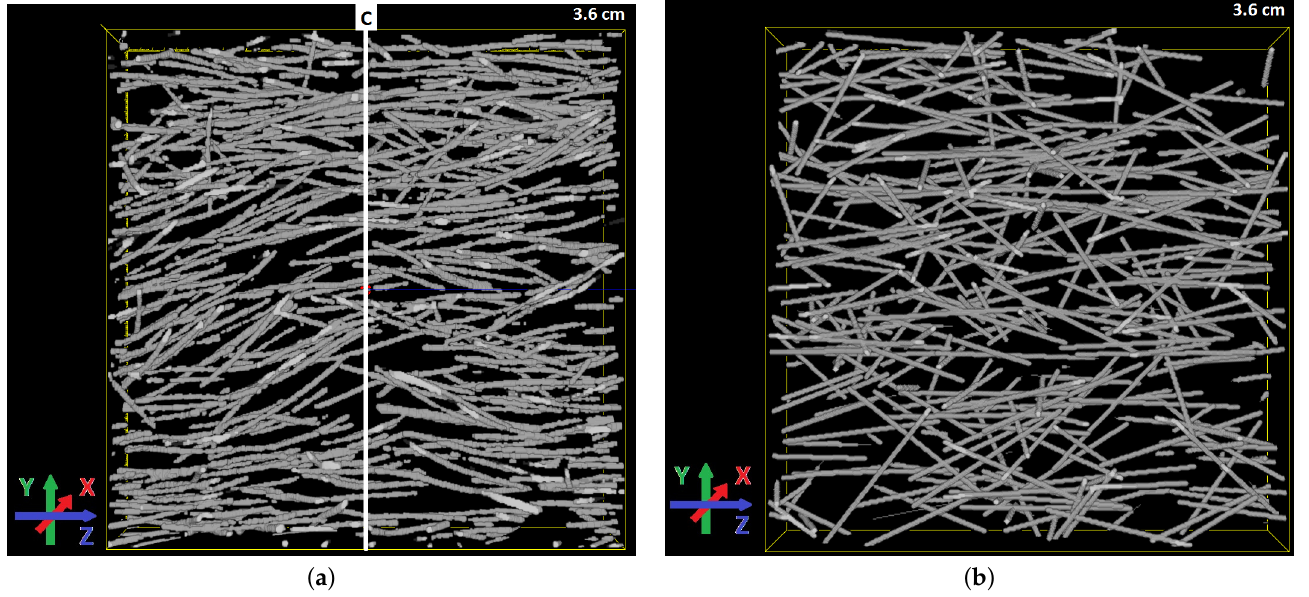
Figure 6. Volume rendering of fibres in the crack area ( a ) and a fitted fibre system ( b ). The subvolume is of dimension 3.6 cm 2 × 0.45 cm. The position of C in ( a ) is indicated by a solid white line.